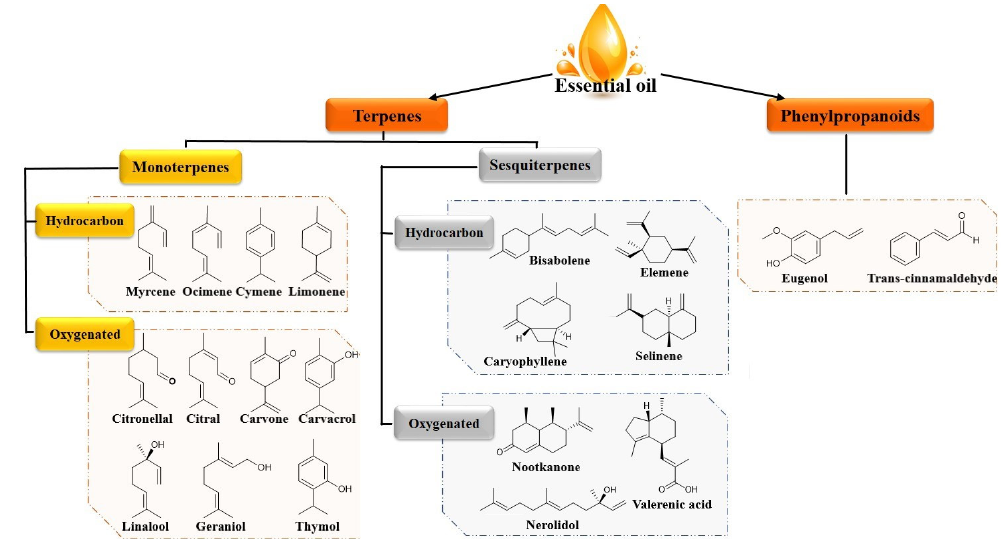
Figure 1. Chemical structures of some constituents of essential oils.